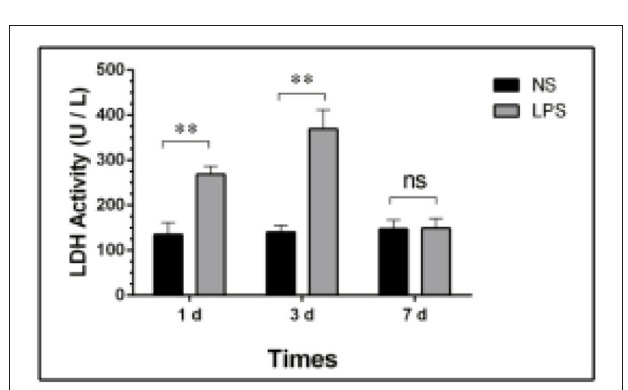
FIGURE 3 | LDH activity in BALF of LPS-induced ALI. Mice were sacrificed on days 1, 3, and 7 after LPS stimulation and BALF were collected for LDH activity detection. BALF, bronchoalveolar lavage fluid; LPS, lipopolysaccharide; ALI, Acute lung injury; ** p < 0.01; ns, no statistical significance. Statistical results were an average of five animals in each